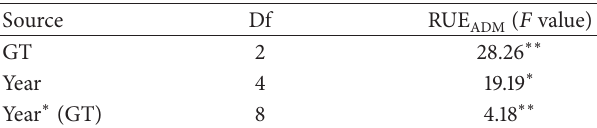
Table 3: 𝐹 values and the probability of ANOVA results on species richness.